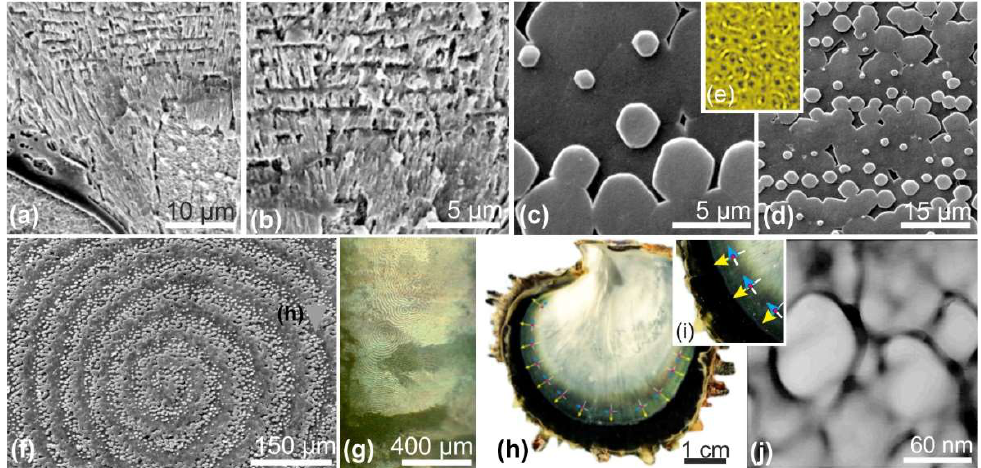
Figure 9. The two-phase process of nacre formation: from pre-nacre to nacreous tablets and overall crystallographic orientation of the nacreous layer of Pinctada . ( a , b ) Persistency of fibrous radial orientation between the parallel organic membranes. ( c , d ) Nacreous tablet growth and ( e ) Alcian blue staining of their initial nodules. ( f ) Regular spiral made by nacreous tablets and ( g ) most common irregular overall arrangement. ( h , i ) View of an inner surface of Pinctada shell showing crystallographic orientations of the nacreous tablets linked to the growth direction (yellow arrows: a , blue: b , red dots: c perpendicular to the shell surface). ( j ) Reticulate crystallization of the grains necessarily controlled at the overall shell level. Credit pictures: (c,d,f) [21].